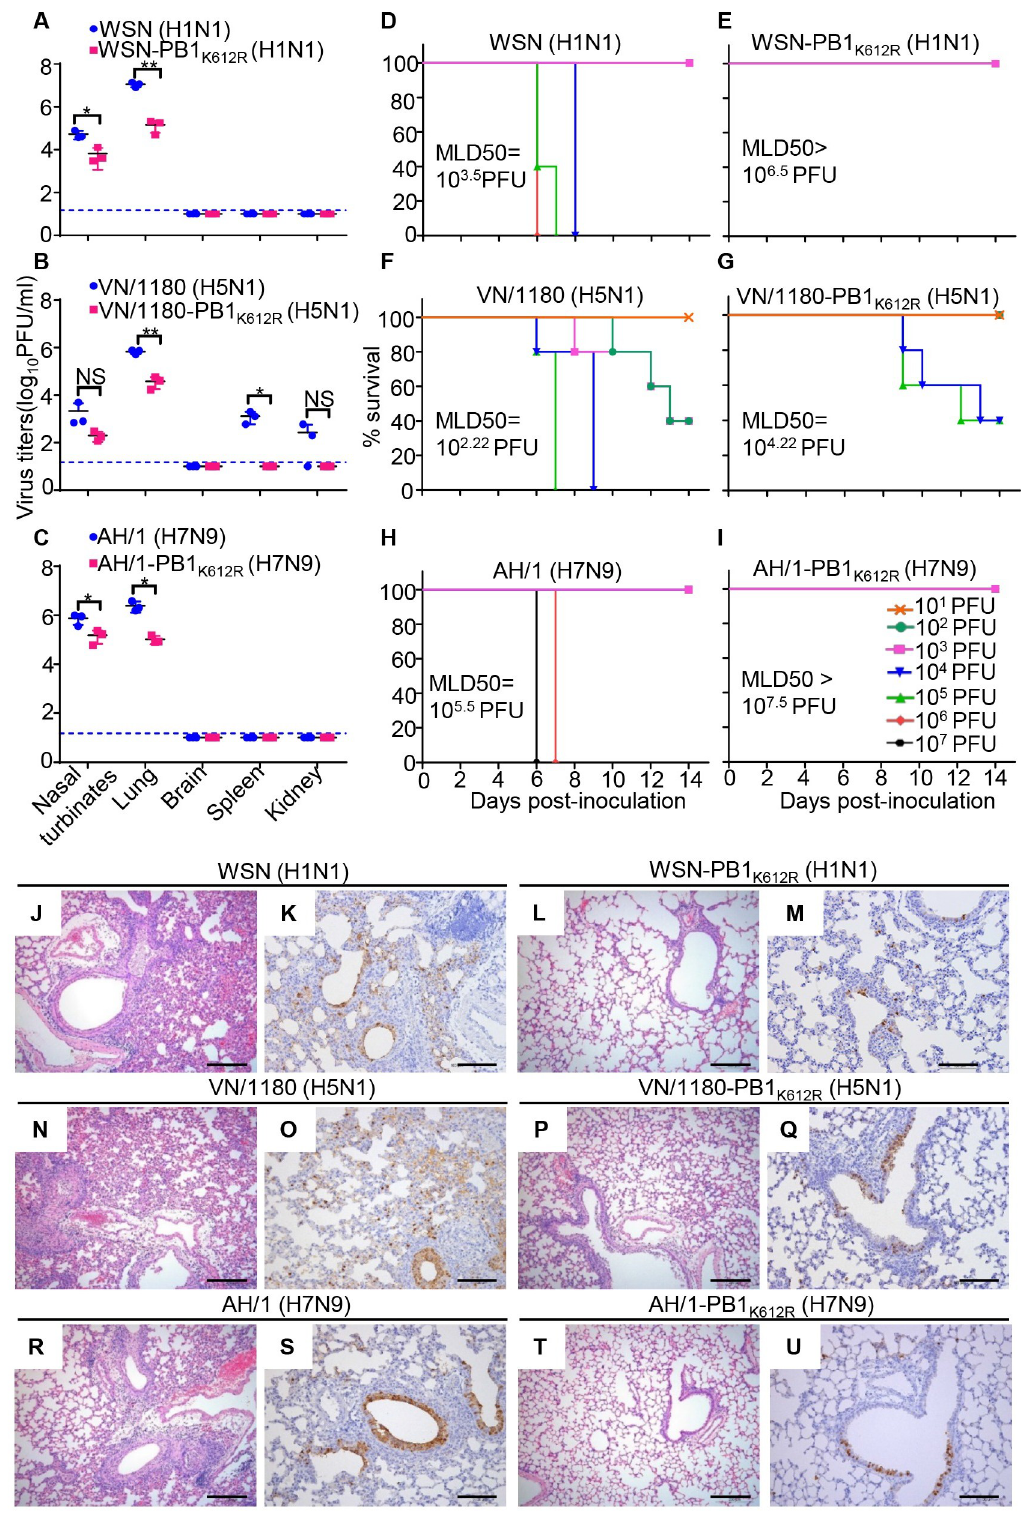
Fig 9. SUMOylation-defective PB1/K612R mutation attenuates the replication and pathogenicity of IAVs in mice. (A) Replication of WSN (H1N1) and WSN-PB1 K612R (H1N1) in mice. Six-week-old BALB/c mice were inoculated intranasally